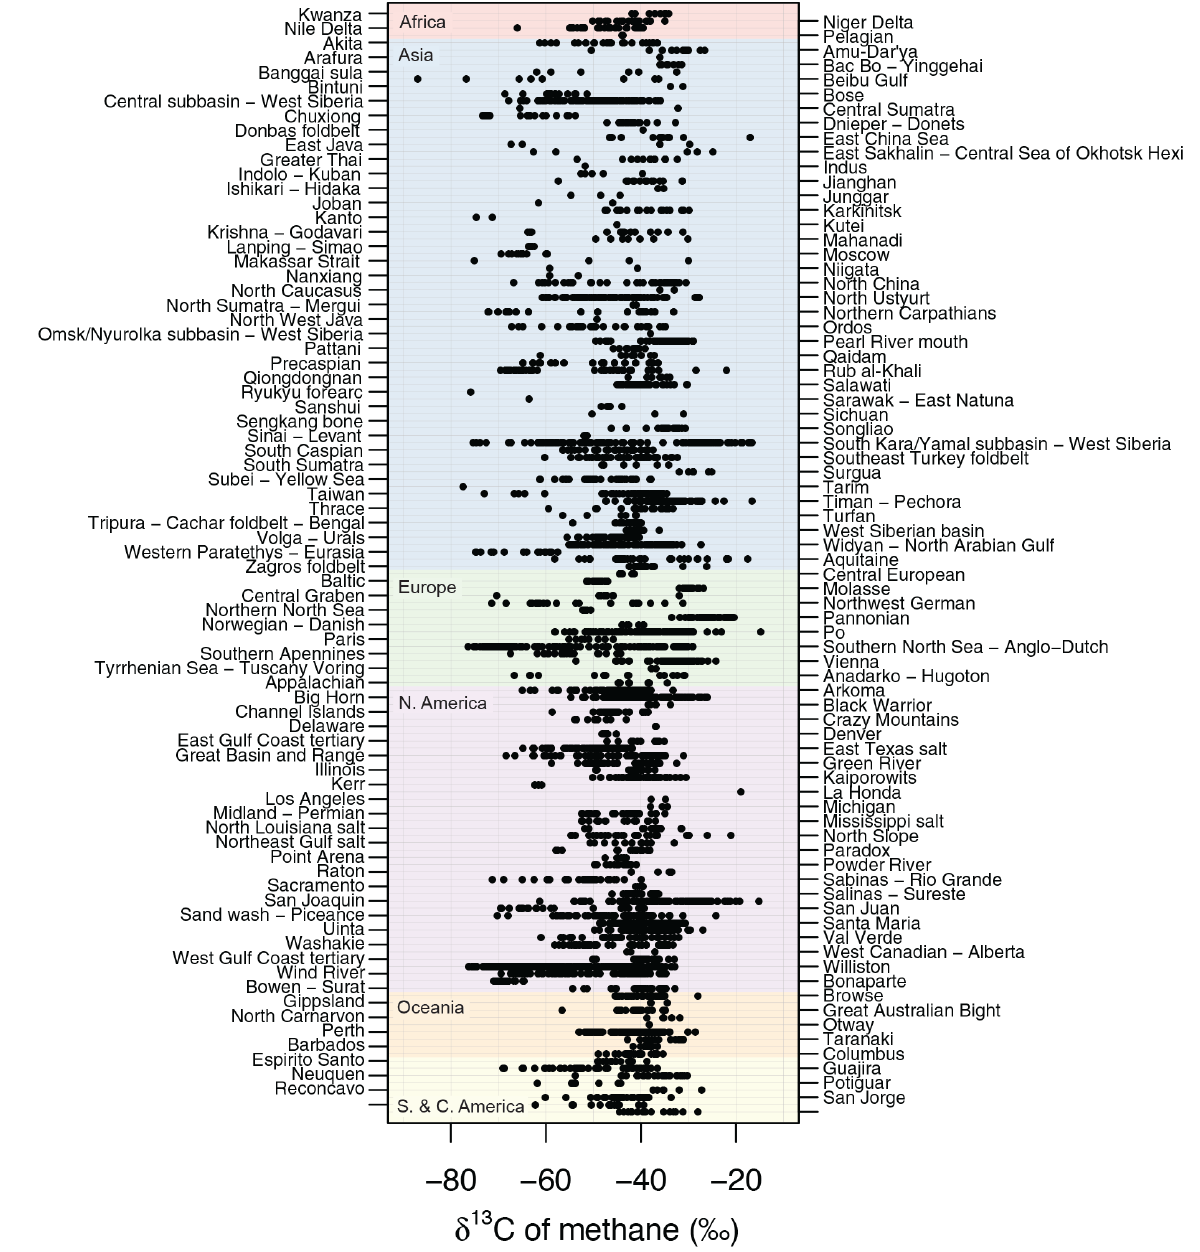
by continent and sedimentary basin, demonstrating high levels of variability within 4